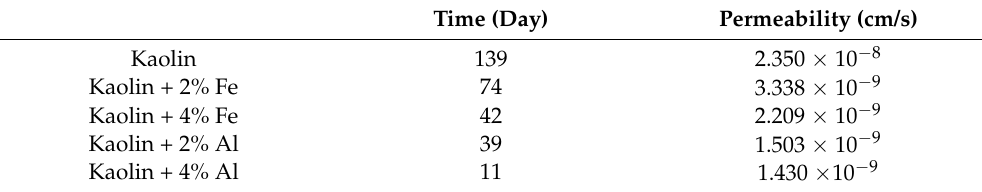
Table 3. Time to reach maximum FR of clay samples with and without nanomaterial